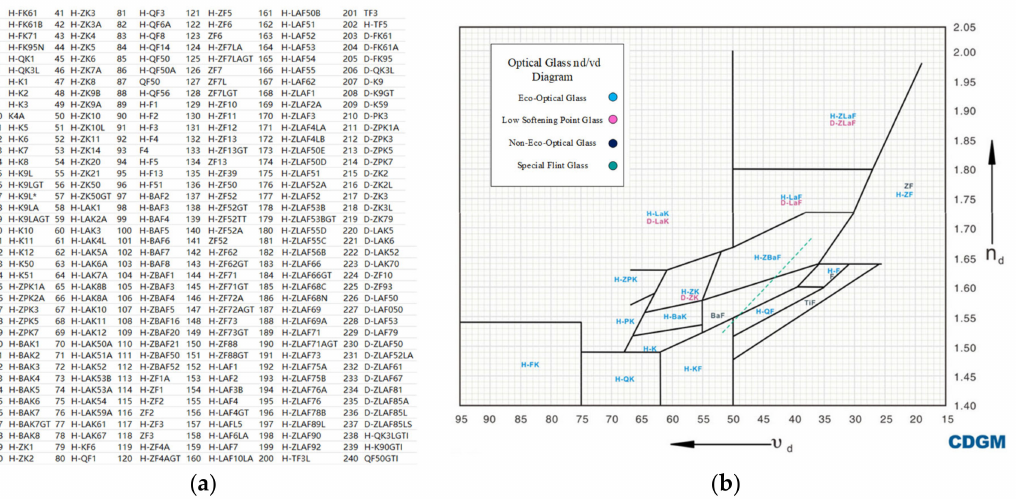
Figure 8. Chengdu Guangming glass ( a ) material catalog, ( b ) n d /v d map.